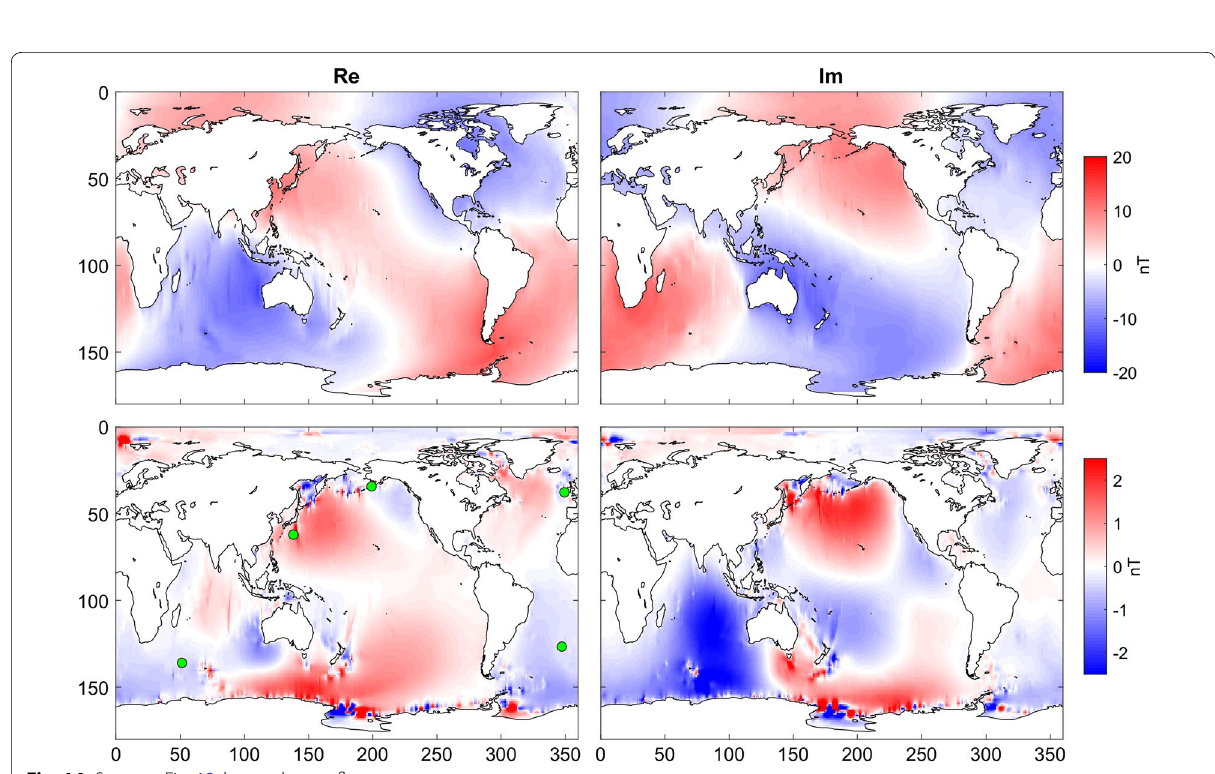
Fig. 14 Same as Fig. 13, but at the sea